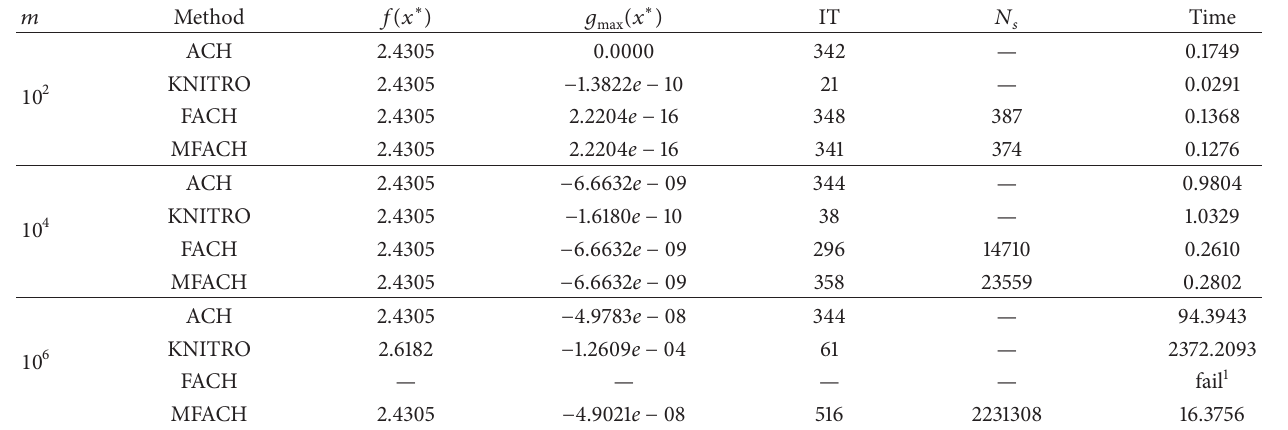
Table 6: Test results for Example